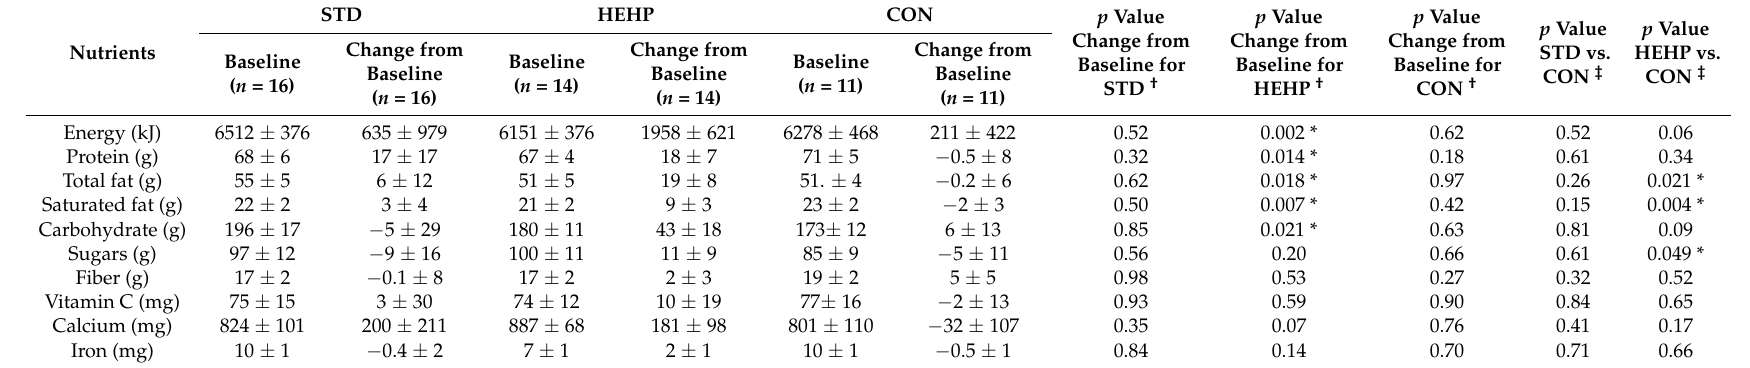
Table 2. Total daily nutrient intakes at baseline and change from baseline to week 12 for STD, HEHP, and CON ˆ#